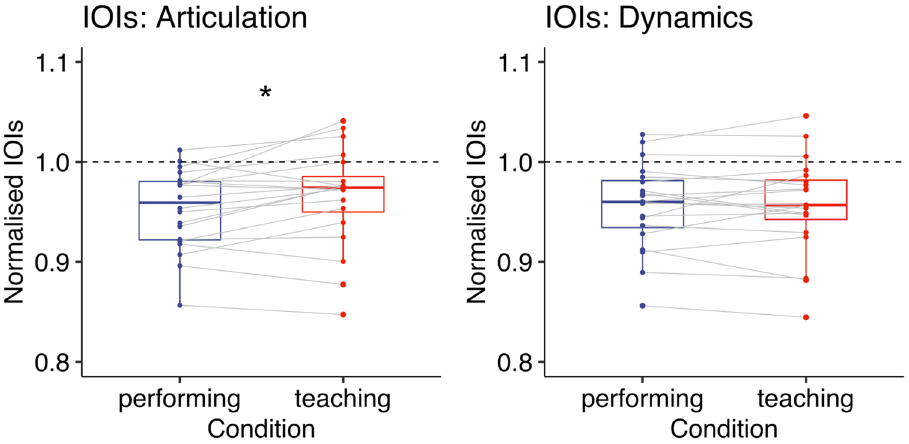
Figure 6. Experiment 2: Normalised IOIs when playing the piece with either articulation (left) or dynamics (right). A dashed line represents the tempo given by a metronome. Each box indicates the IQR with the median, and whiskers extend to a maximum of 1.5 × IQR beyond the box. Significance levels: * < 0.05, ** < 0.01, *** < 0.001.